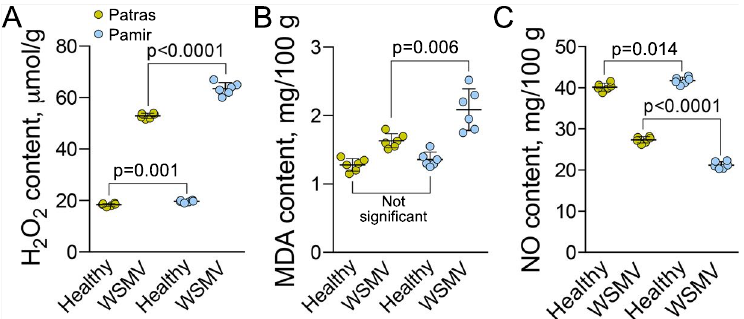
Figure 4. Analysis of oxidative stress in leaves of plants infected by WSMV. ( A ), Content of hydrogen peroxide per gram of leaf fresh weight in healthy and WSMV-infected plants. ( B , C ), Content of malondialdehyde (MDA; B ) and nitrogen monoxide (NO; C ) per 100 g of leaf fresh weight in healthy and WSMV-infected plants. Six biological replicates (individual plants) were measured per each treatment. p values were calculated using non-paired t -test.